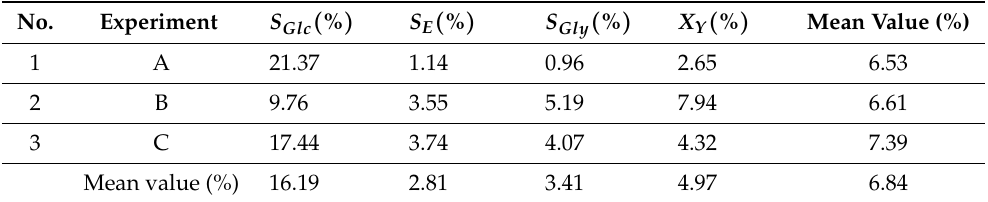
Table 4. Mean relative errors reported between model output and experimental data under completely anaerobic